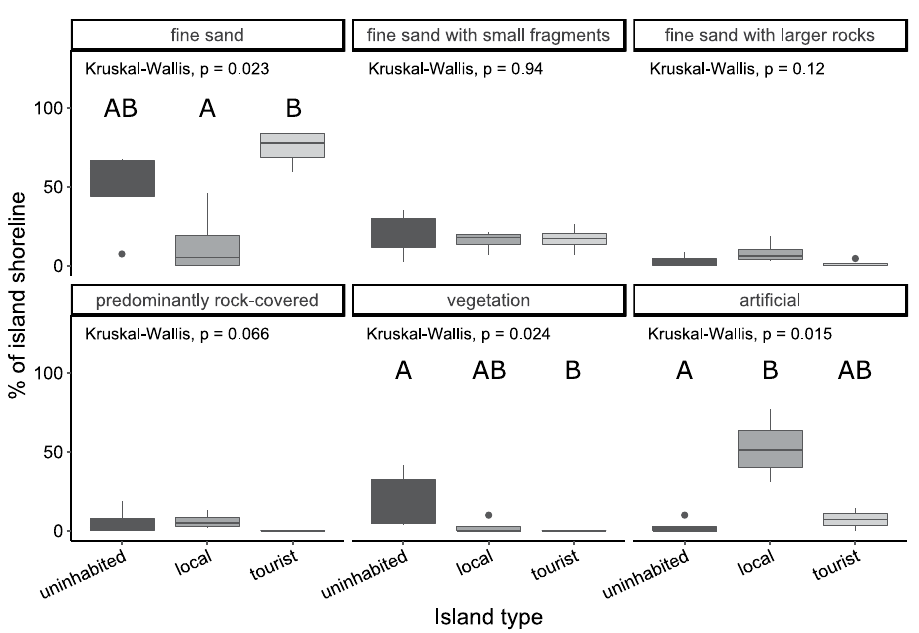
Figure 3. Beach habitat composition of the three island types. Proportions of each of the six categorized beach types on the three investigated island types ( N = 4). Significant differences in the pairwise comparisons between island types are indicated by different